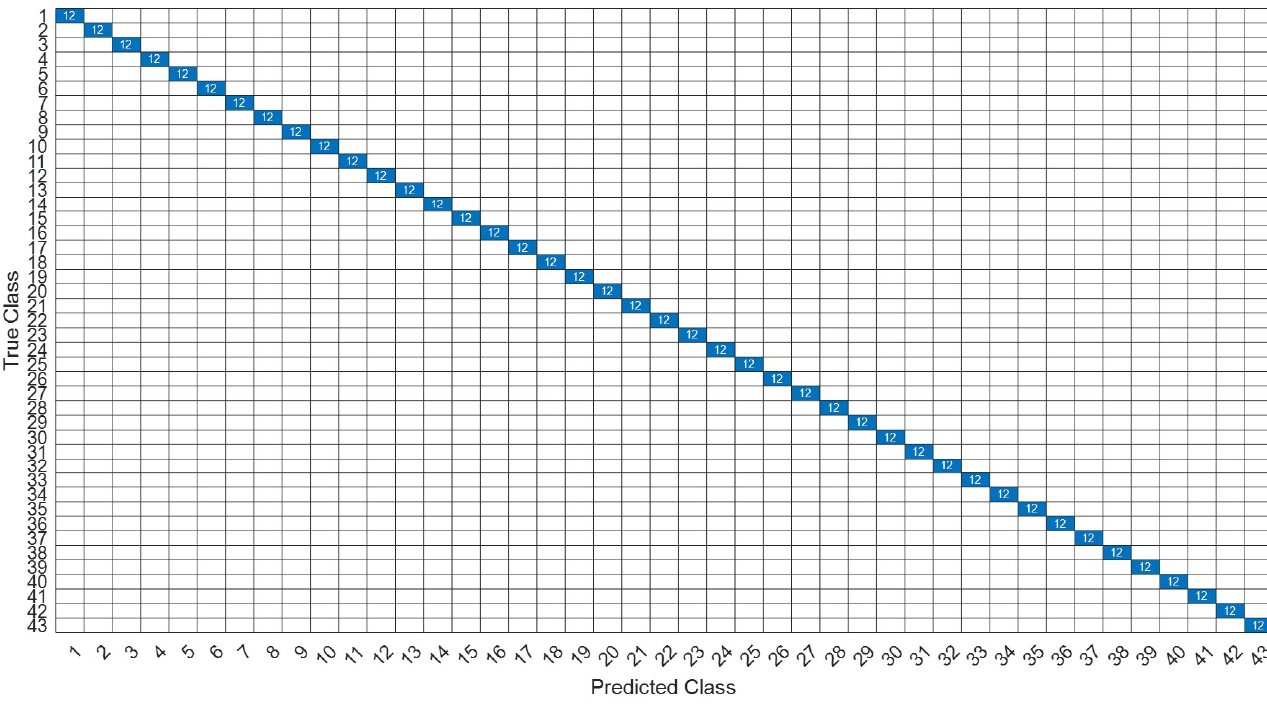
Figure 31. The confusion matrix of the DNN model with wavelet 40-features dataset.